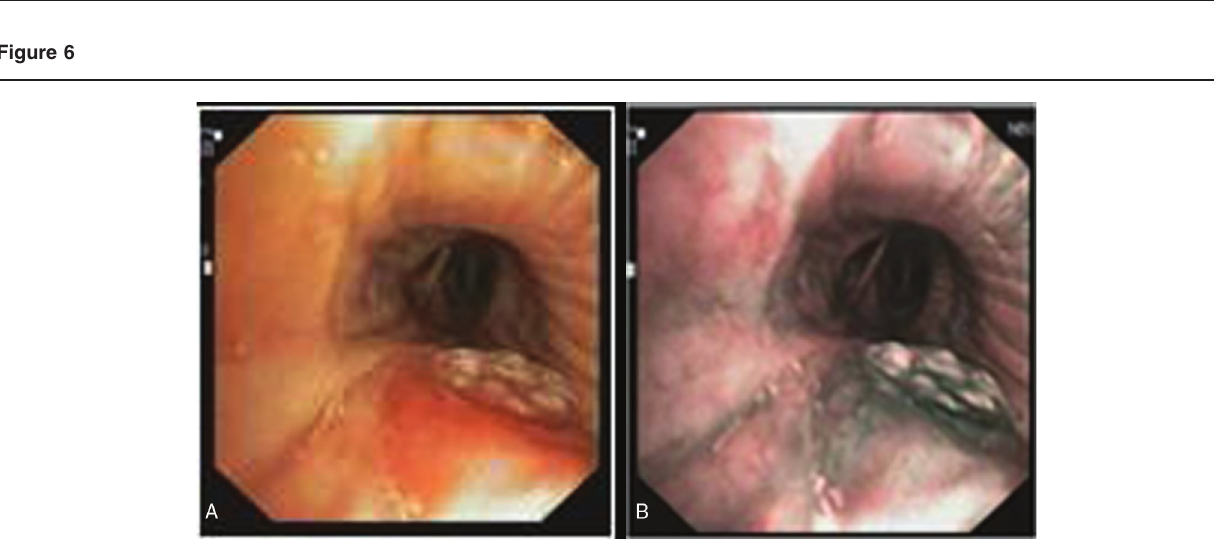
positive histopathological results. Also, three of them were negative by histopathology (false positive).